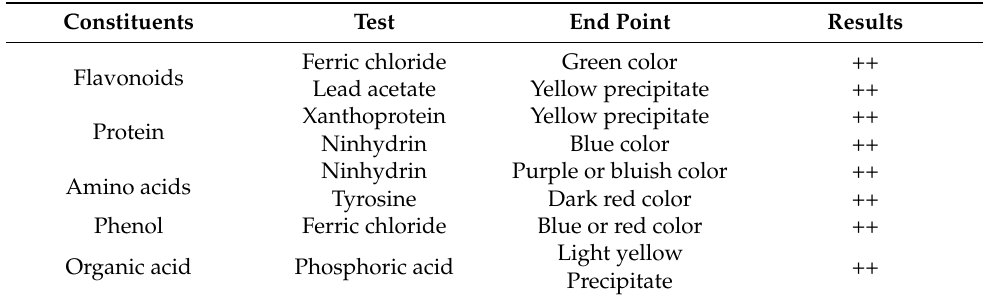
Table 2. Screening of phytochemical constituents of Vigna radiata .